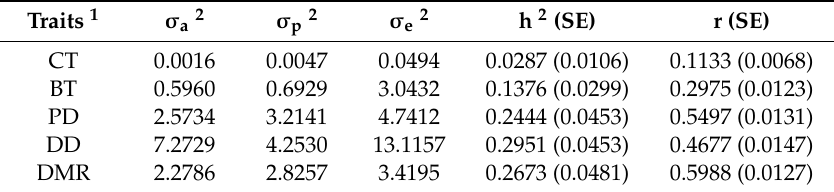
Table 3. Genetic parameters for five types of sperm morphology abnormalities estimated by a single-trait linear mixed model in the Duroc boar population.